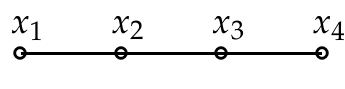
Figure 2. Graph P 3